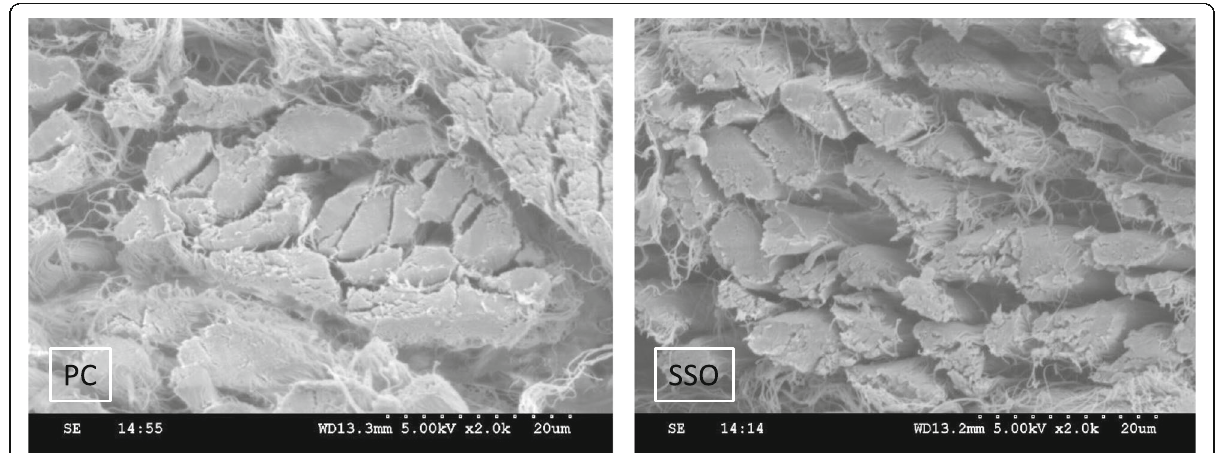
Fig. 7 Scanning electron microscopy results for the leather test pieces, PC, and SSO. (Magnification: X